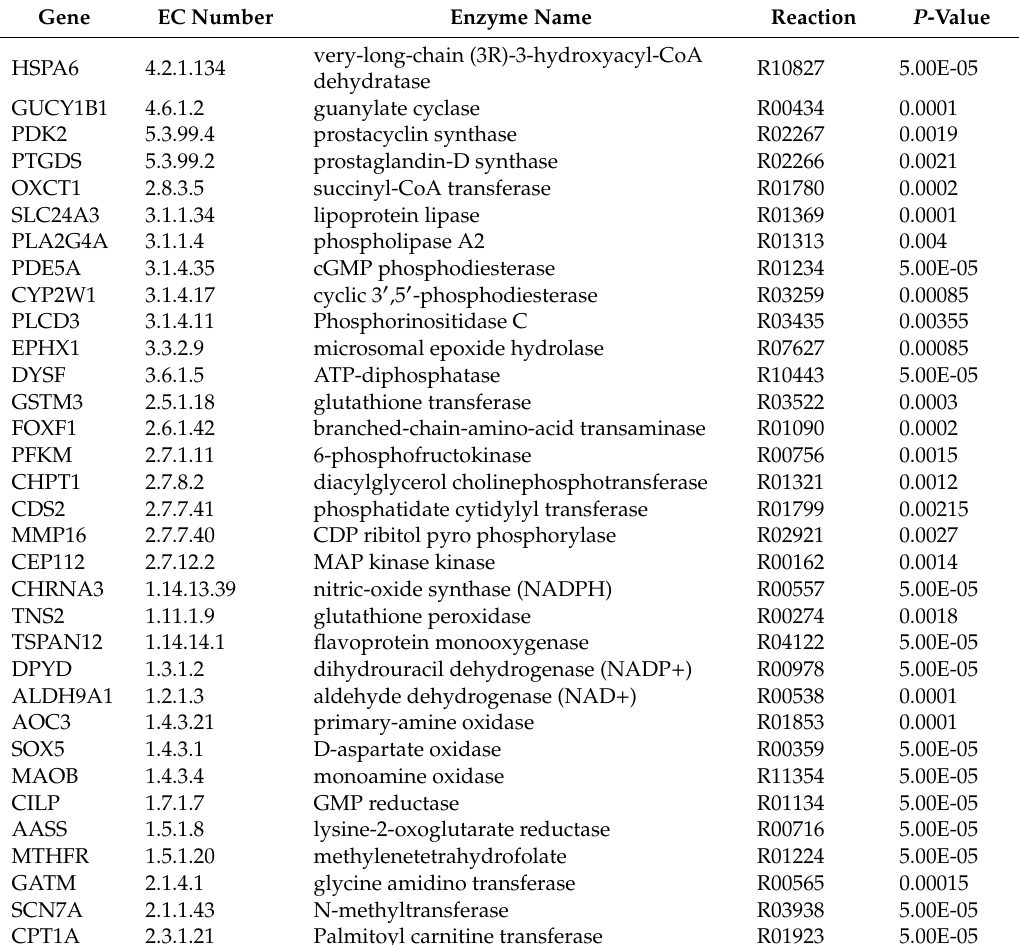
Table 4. The top up-regulated enzyme in the bovine rumen tissue under acidosis condition.